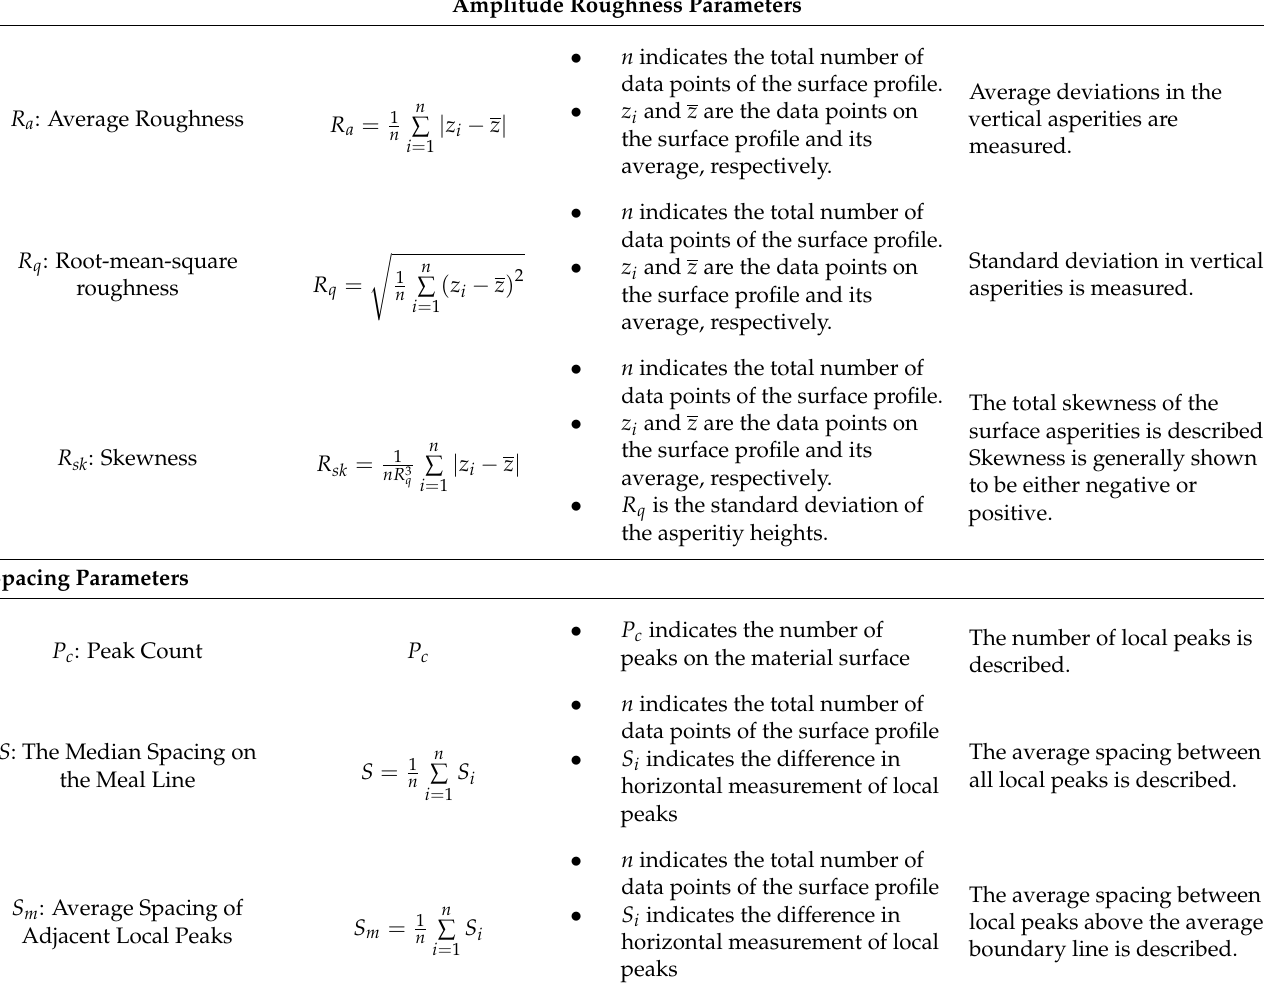
Table 2. General surface roughness parameters from ISO 25178 [53], ISO 4287 [52], and from Tribology for Scientists and Engineers